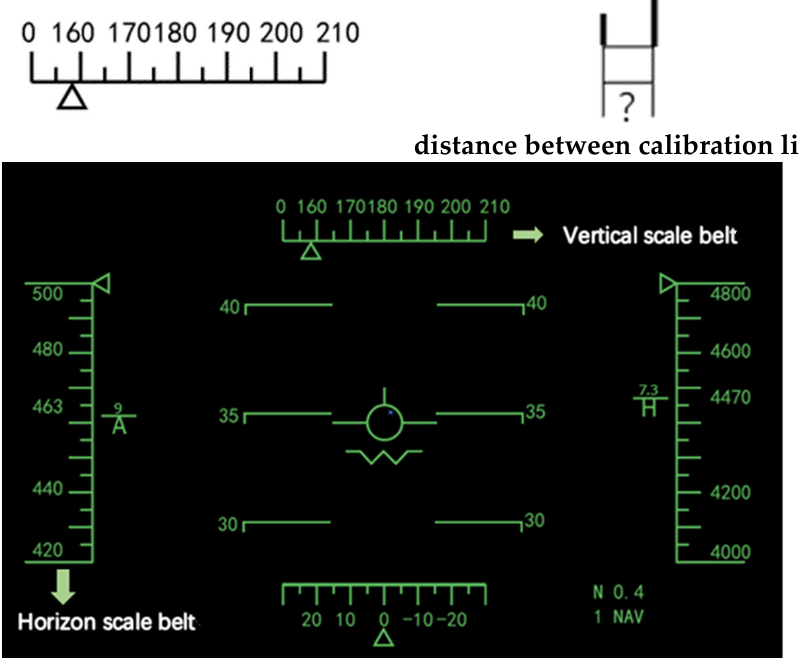
Figure 1. Calibration scale belt (vertical and horizon) and distance between calibration lines.